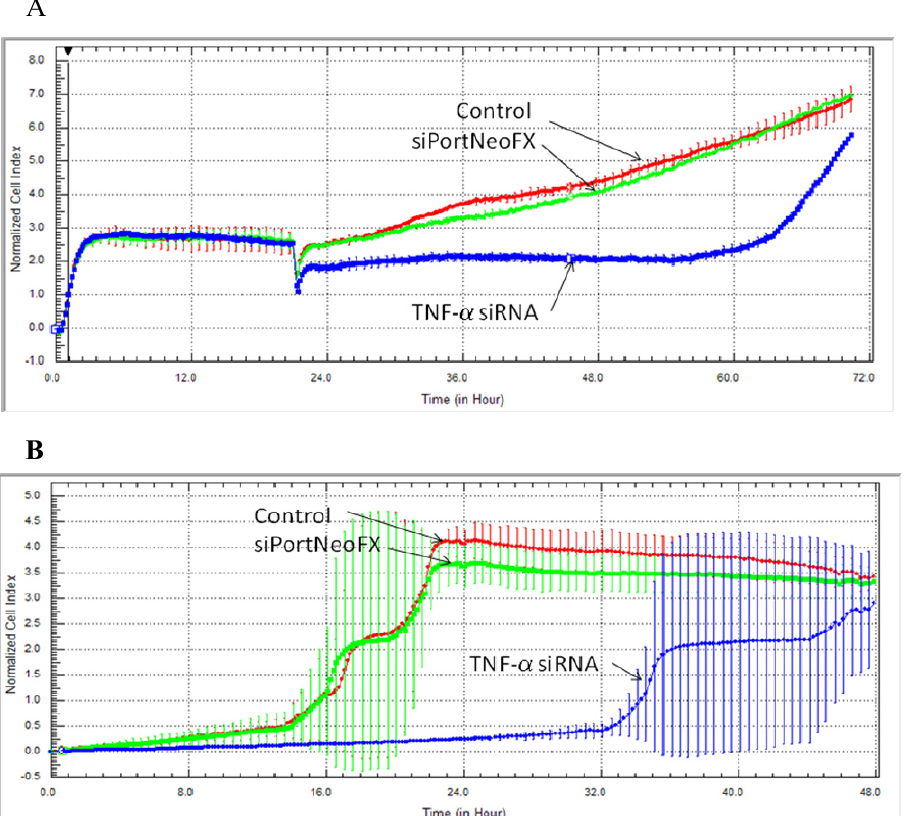
Figure 1. Time kinetics of cell growth ( A ) and migration ( B ) after TNF- α knock-down with the RTCA